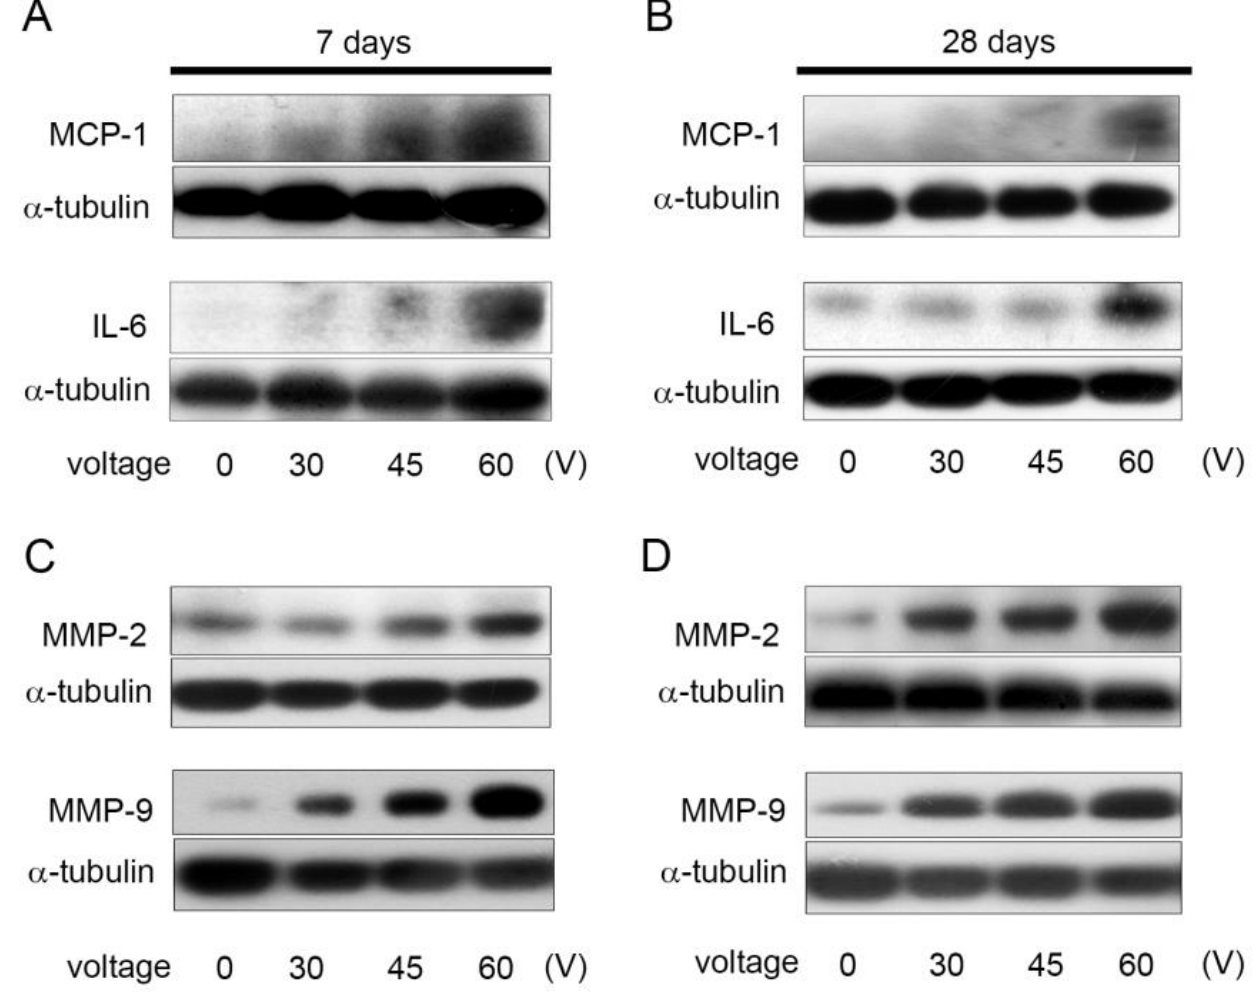
Figure 3. Effects of PRF treatment on the expression of pain-related cytokines and matrix metalloproteinases. Rats were stimulated with PRF at the indicated intensities (30 V, 45 V, and 60 V), followed by 7 ( A , C ) or 28 ( B , D ) days of rest. Then, the left dorsal horn of rats was harvested and subjected to Western blot analysis. MCP-1, IL-6, MMP-2, and MMP-9 were identified. α-tubulin was used as a loading control.